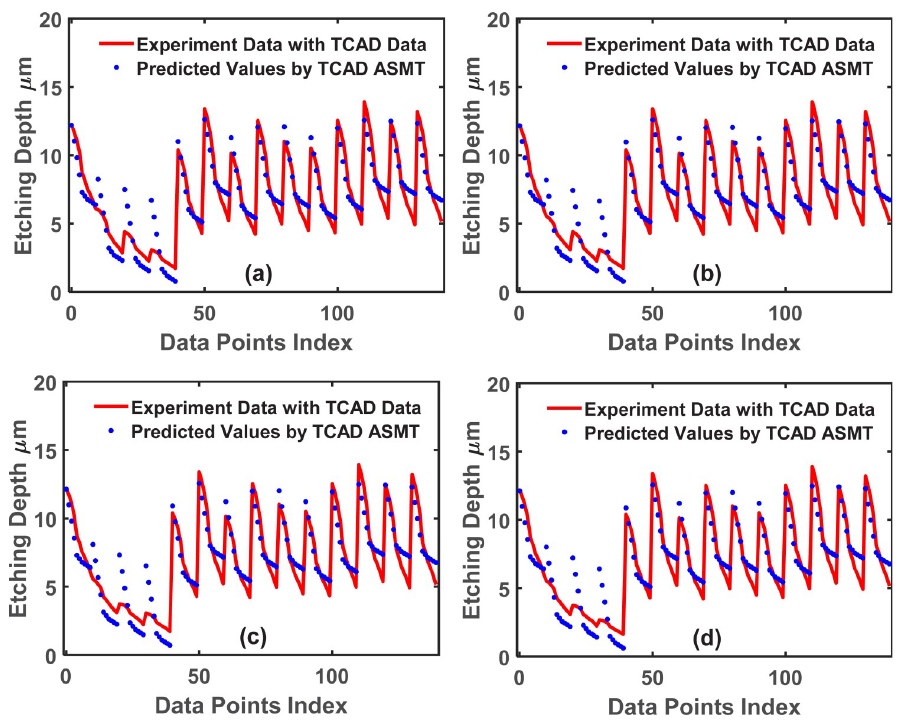
Fig 14. Training set fitting for the 5-input dataset using the TCAD-labeled ASMT algorithm. The partition values, 10, 20, 30, and 40, are shown in (a), (b), (c)and (d), respectively.